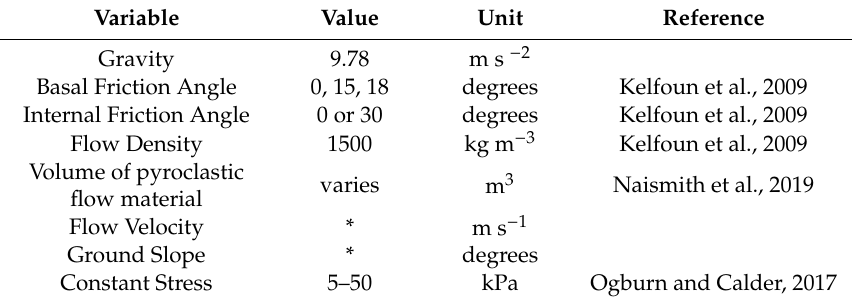
Table 2. Primary variables used in the VolcFlow model. * denotes variables that vary during the calculations in time or in space during the model